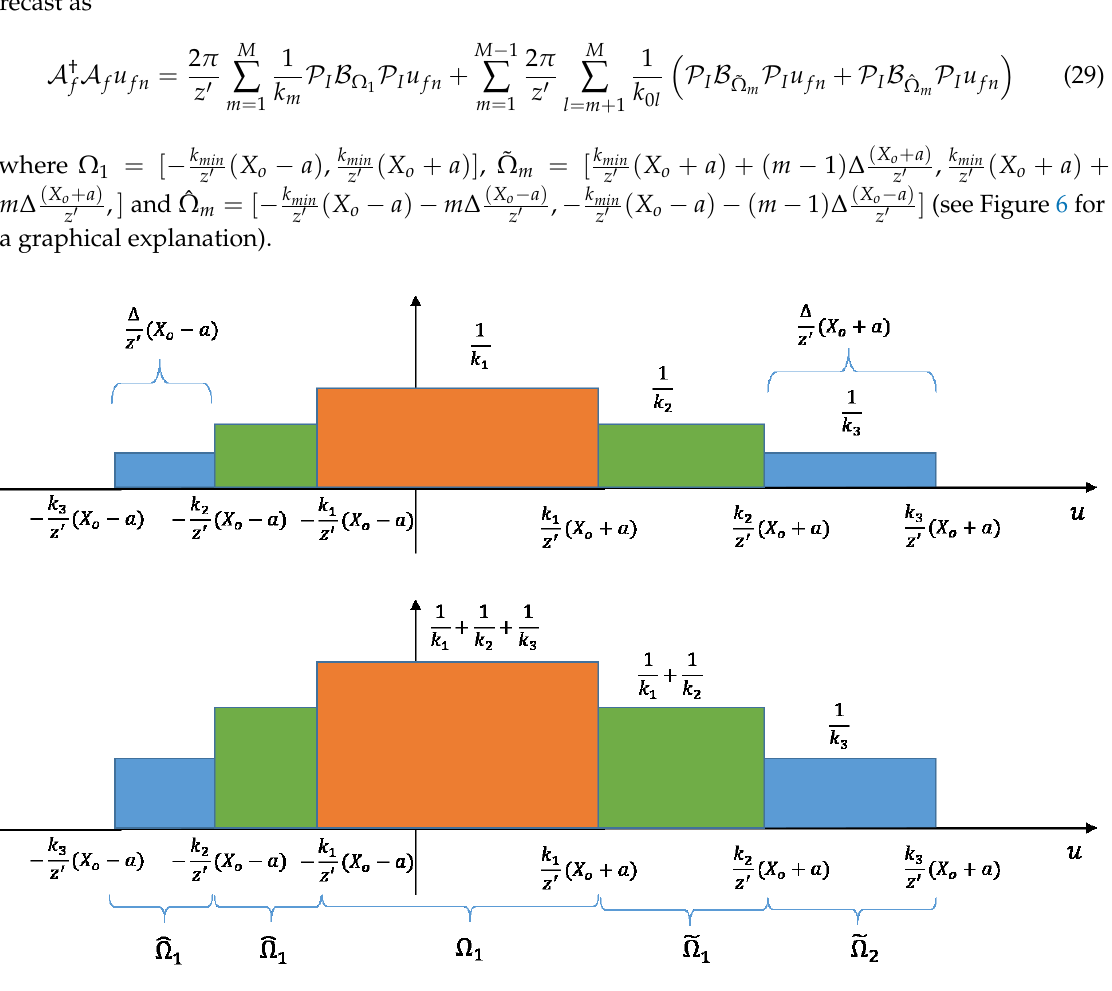
Figure 6. Illustration of how to rearrange the frequency bands to obtain Equation (29) with the assumption X 0 > a